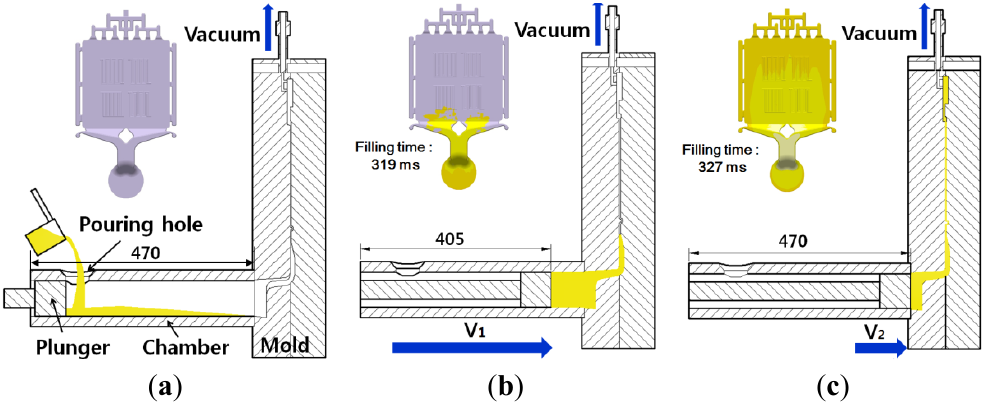
Figure 4. Vacuum die casting process: ( a ) Input melt in chamber; ( b ) Slow shot and ( c ) Fast shot. Table 1. Process parameters of vacuum cold chamber die-casting.